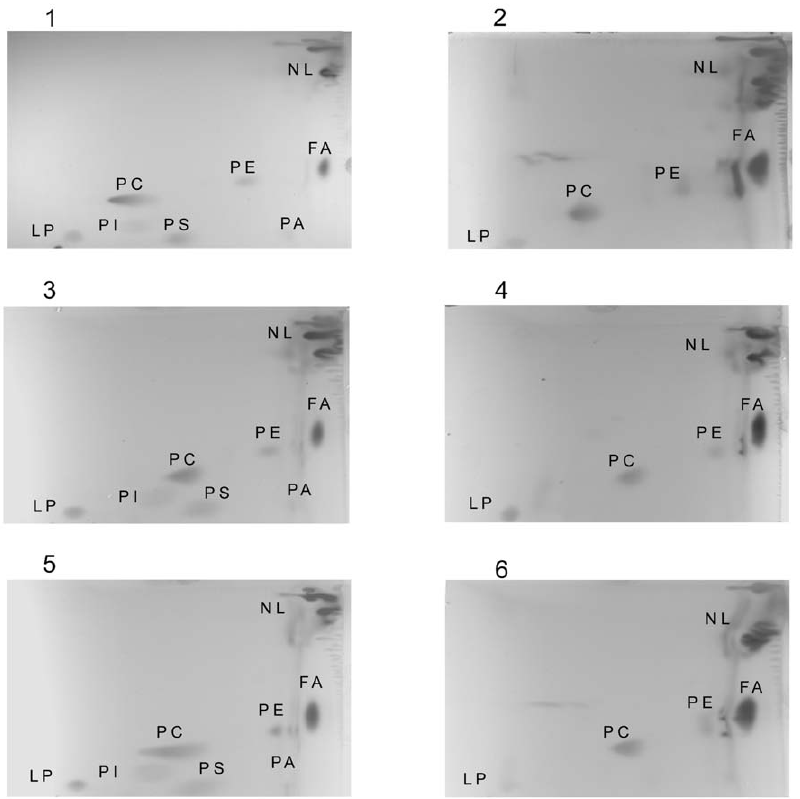
Figure 5. Two dimensional chromatography of glycerophospholipids. The levels of all major glycerophospholipids were diminished by treatment with simvastatin. Panels: 1, 3, 5 glycerophospholipids from cells harbouring the wild-type yeast, or the wild-type or mutated hHMGR gene, respectively. Panels 2, 4, 6 glycerophospholipids from simvastatin treated cells harbouring the wild-type yeast, or the wild-type or mutated hHMGR gene, respectively. Abbreviations: PC phosphtidylcholine, PE phosphtidylethanolamine, PS phosphatidylserine, PI phosphtidylinositol, PA phosphtidic acid, LP lysoglycerophospholipid, FA fatty acid, NL neutral lipids.